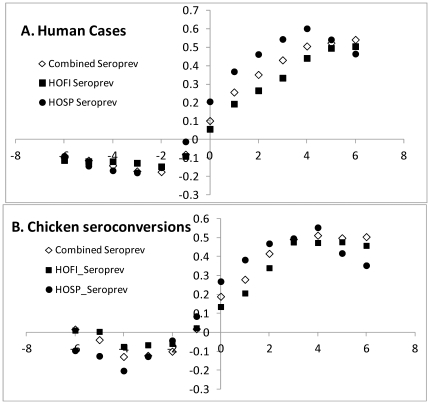
Cross correlations for House Finch (HOFI), House Sparrow (HOSP) and combined seroprevalence against A) Human cases of West Nile neuroinvasive disease and B) sentinel chicken seroconversions.